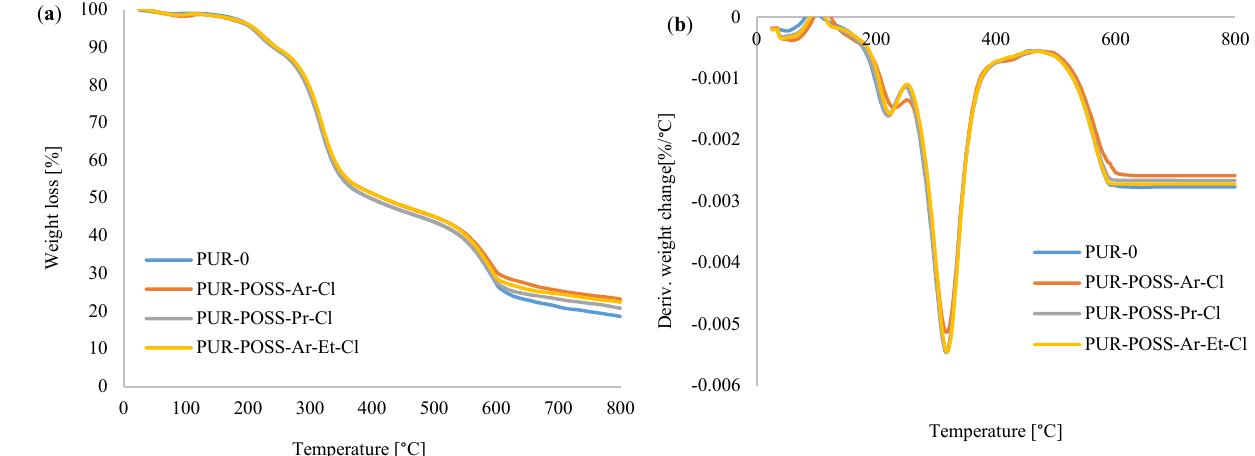
Figure 6. ( a ) TGA and ( b ) DTG curves for PUR foams modified with POSS-Cl.